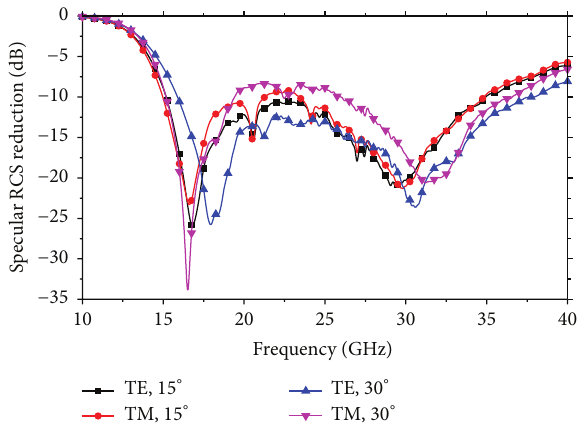
Figure 17: Simulated RCS reduction in specular direction for oblique incidence.